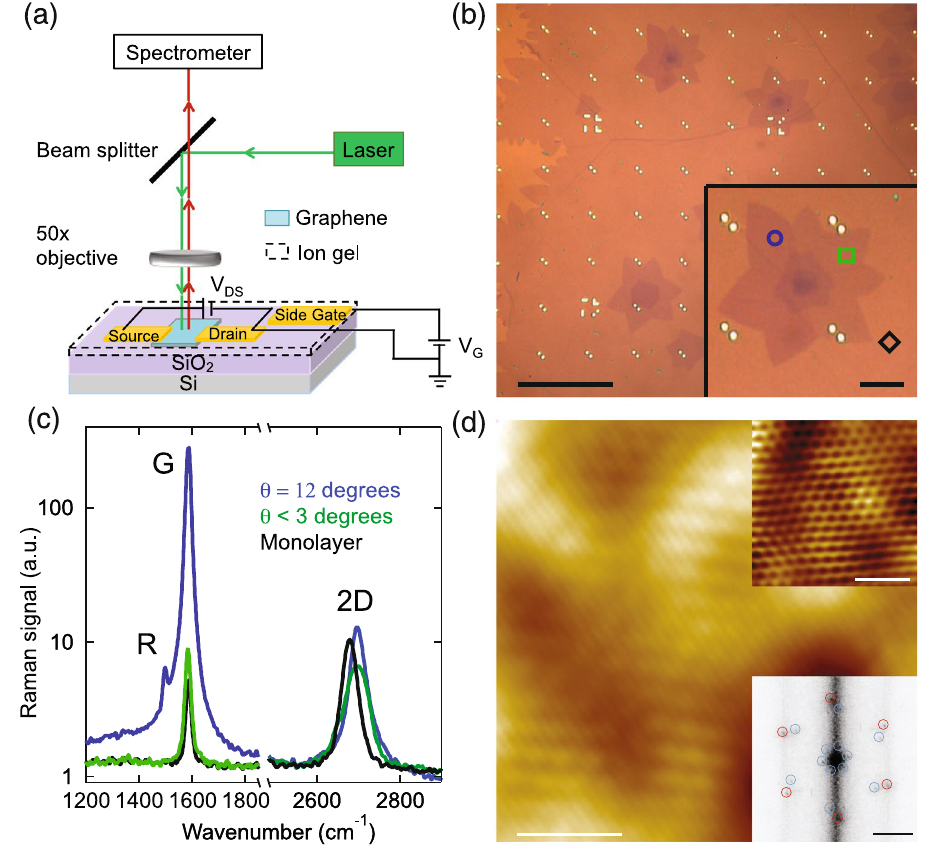
Figure 1. ( a ) Schematic diagram of the experimental layout. ( b ) Optical microscope image of CVD grown graphene flakes. Bright dots are gold coordinate markers on the SiO 2 /Si substrate. The inset is a zoomed in image of a multilayer graphene flake. Blue circle, green square and black diamond are locations where the Raman spectra in ( c ) are acquired. Scale bars in the main image and the inset are 50 μ m and 10 μ m respectively. ( c ) Raman spectra at the marked locations in ( b ). The black diamond is on monolayer graphene while the other two locations are from tBLG. Only wavenumber ranges near the G and 2D peaks are shown.( d ) STM topography image of tBLG showing a 1.19 ± 0.03 nm moiré pattern. Sample voltage is 0.3 V and tunnel current is 100 pA. Scale bar in the figure is 4 nm. The upper inset is a zoom-in image showing the atomic lattice. Scale bar is 1 nm. The lower inset is the FFT of the topography showing the atomic lattice and moiré pattern features, red and blue circles respectively. Scale bar is 10 nm − 1